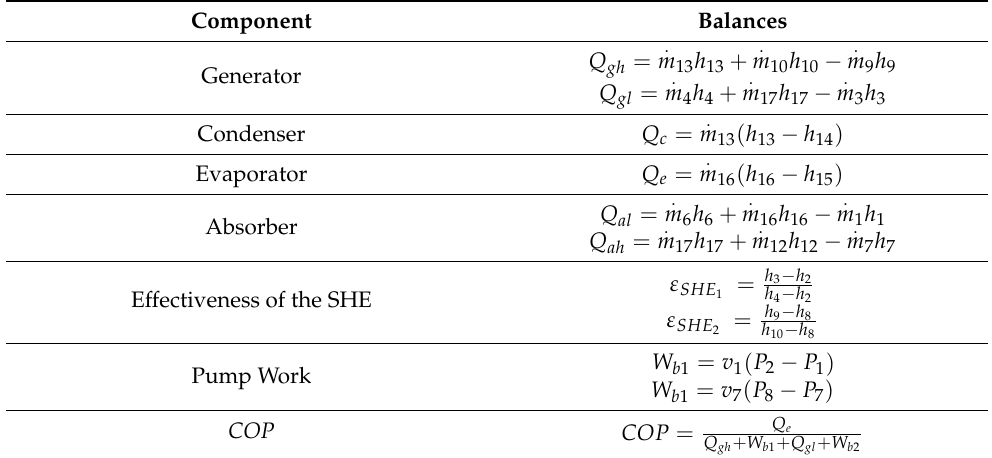
Table A2. Energy balances for each one of the components of the half-effect absorption cooling system.